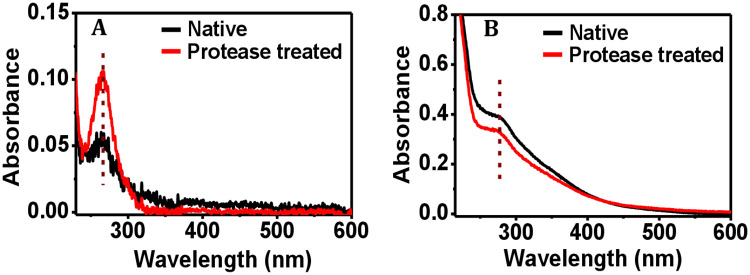
Effect of bacterial protease on the UV-visible spectrophotometric data of proteins.Representative UV-Vis spectra of (A) collagen, and (B) ferritin, before and after addition of bacterial protease. The peak positions are shown by the segmented lines.